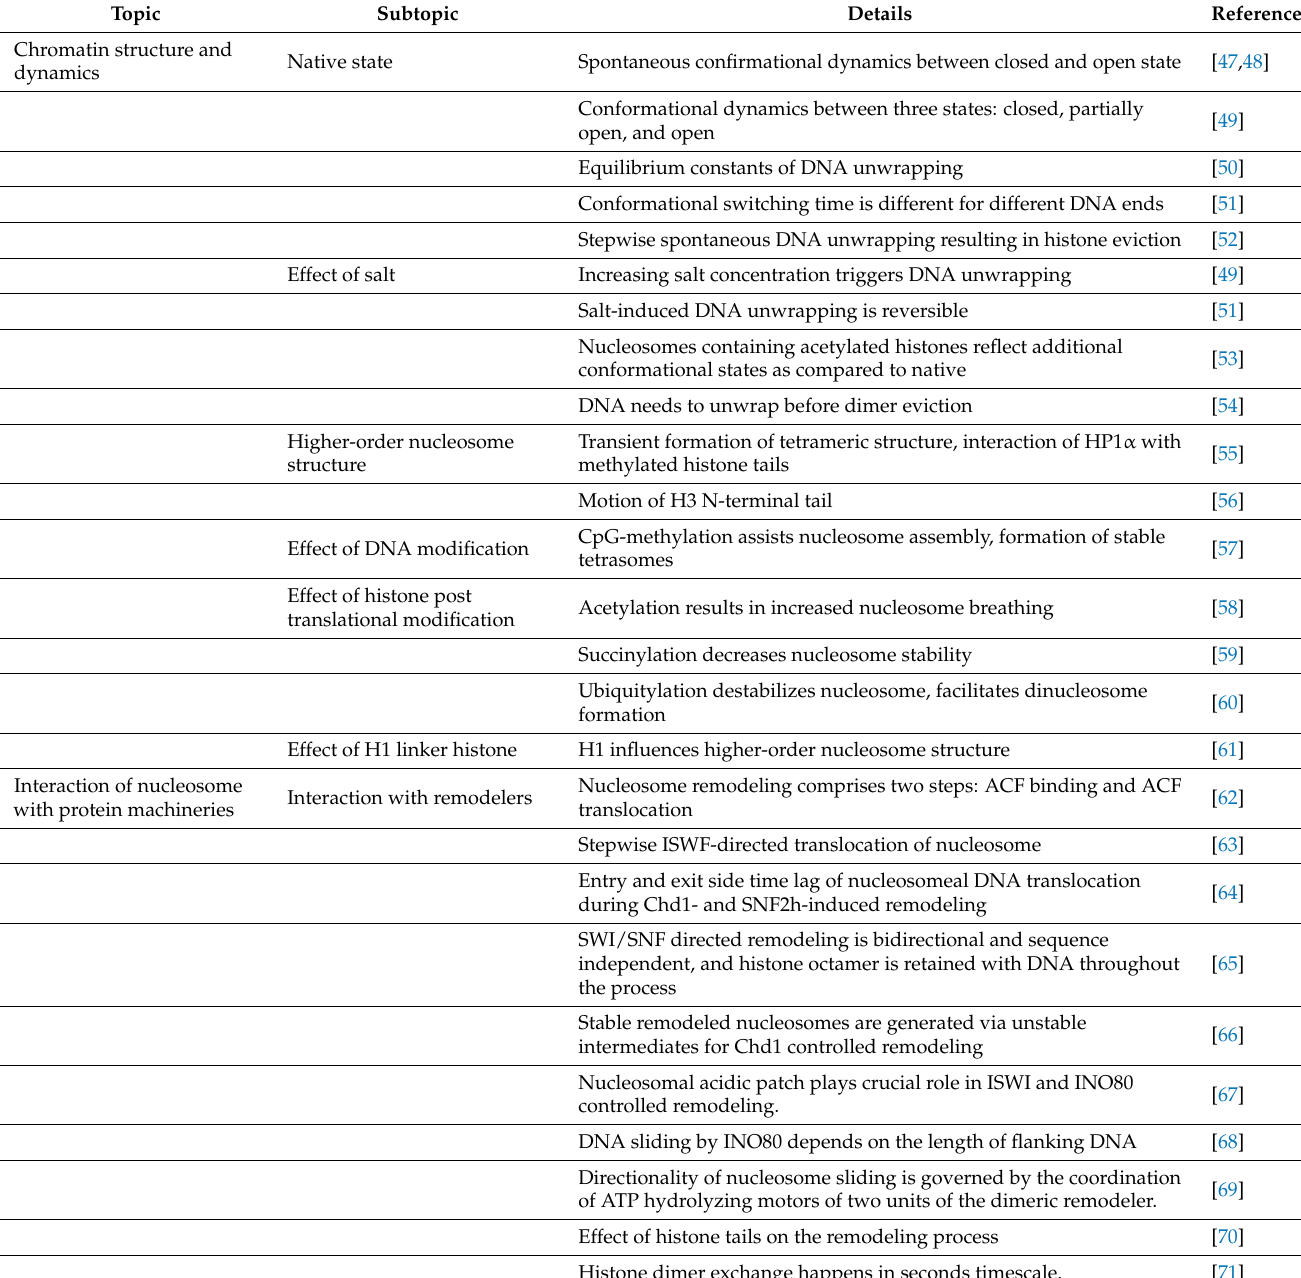
Table 1. Summary of research works focused on the application of smFRET to understand the structure, dynamics and behavior of